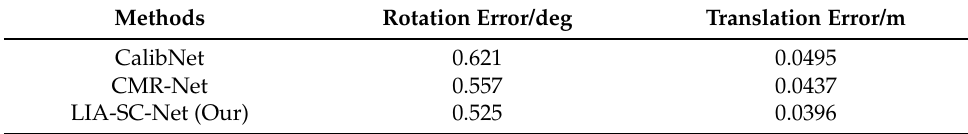
Figure 8. Calibration performance of deep learning based methods in the validation dataset. Table 6. Average calibration errors of deep learning based methods in the validation dataset.